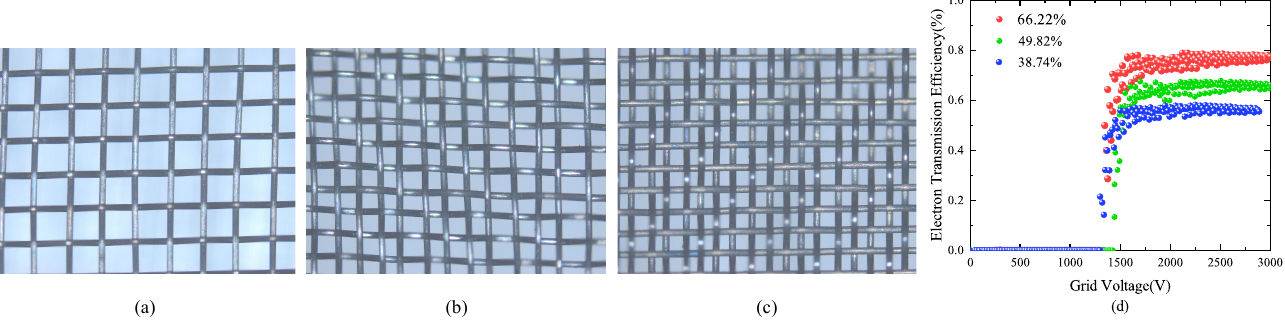
Figure 11. Physical diagram of grid and experimental data diagram of electron transmission efficiency. ( a ) Molybdenum mesh with aperture ratio of 66.22%. ( b ) Molybdenum mesh with aperture ratio of 49.82%. ( c ) Molybdenum mesh with aperture ratio of 38.74%. ( d ) Influence of grid voltage on electron transmission